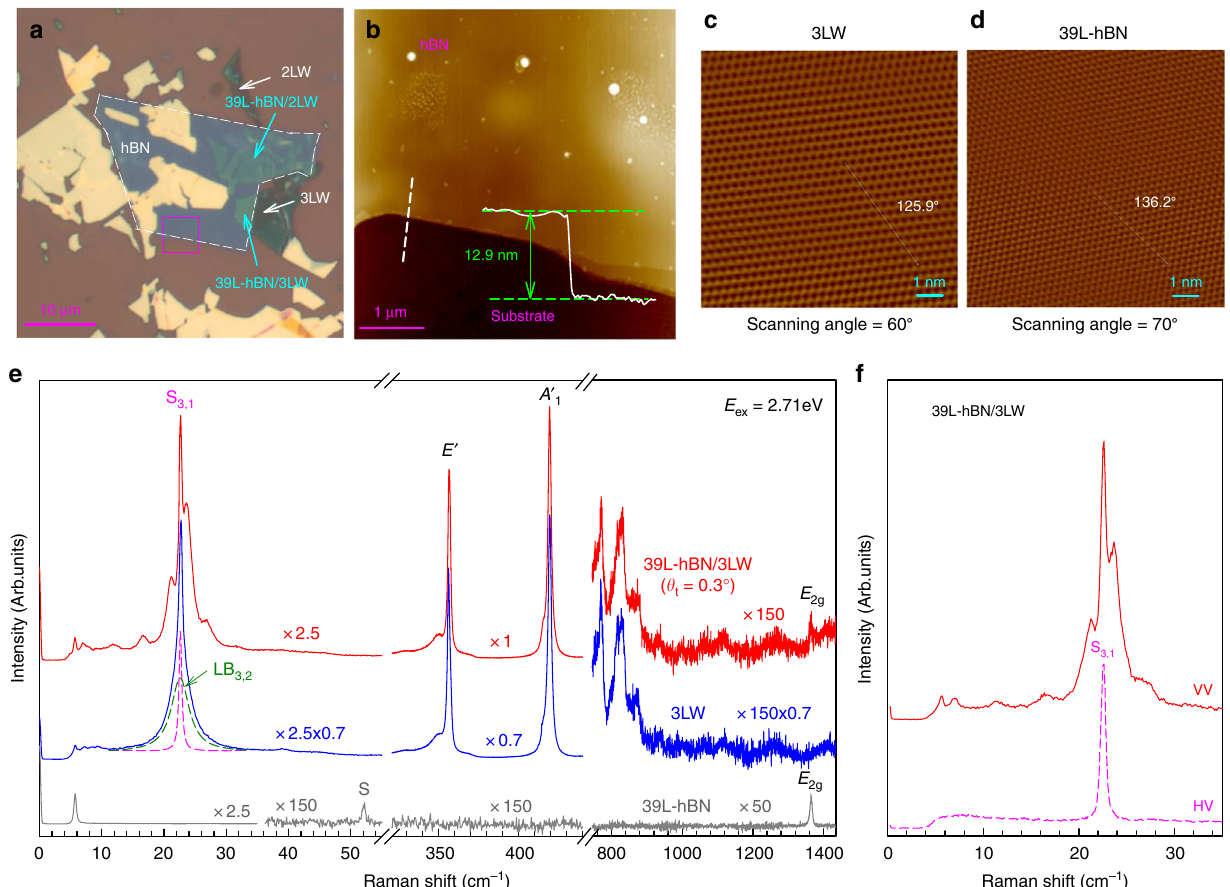
Fig. 1 Characterizations and Raman spectra of the 3LW fl ake and hBN/3LW vdWHs. a Optical images of 2LW, 3LW, 39L-hBN/2LW and 39L-hBN/3LW. b AFM image of the hBN fl ake with thickness of 12.9 nm in pink box of a . The atomic lattice images of c 3LW and d 39L-hBN fl akes. The dashed white lines in c , d represent the lattice orientations of 3LW and 39L-hBN are 125.9° and 136.2°, respectively. The scanning angles are 60° and 70° for 3LW and 39L- hBN, respectively. The twist angle θ t between the 39L-hBN and 3LW fl akes is 0.3°. e Raman spectra of 39L-hBN, 3LW and 39L-hBN/3LW. The green dash pro fi le depicts the LB 3,2 mode in 3LW while the pink dash pro fi le represents the S 3,1 mode. The spectra are scaled and offset for clarify and the scale factors are shown. f The polarized (VV) and depolarized (HV) Raman spectra of